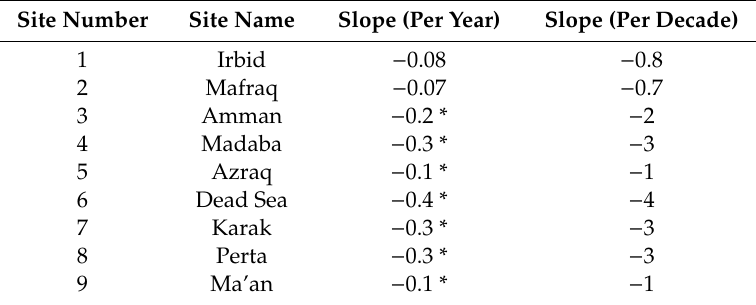
Table 3. Mann–Kendal trend test predicted by Sen’s slope estimator for yearly mean dew yield during 1979–2018.